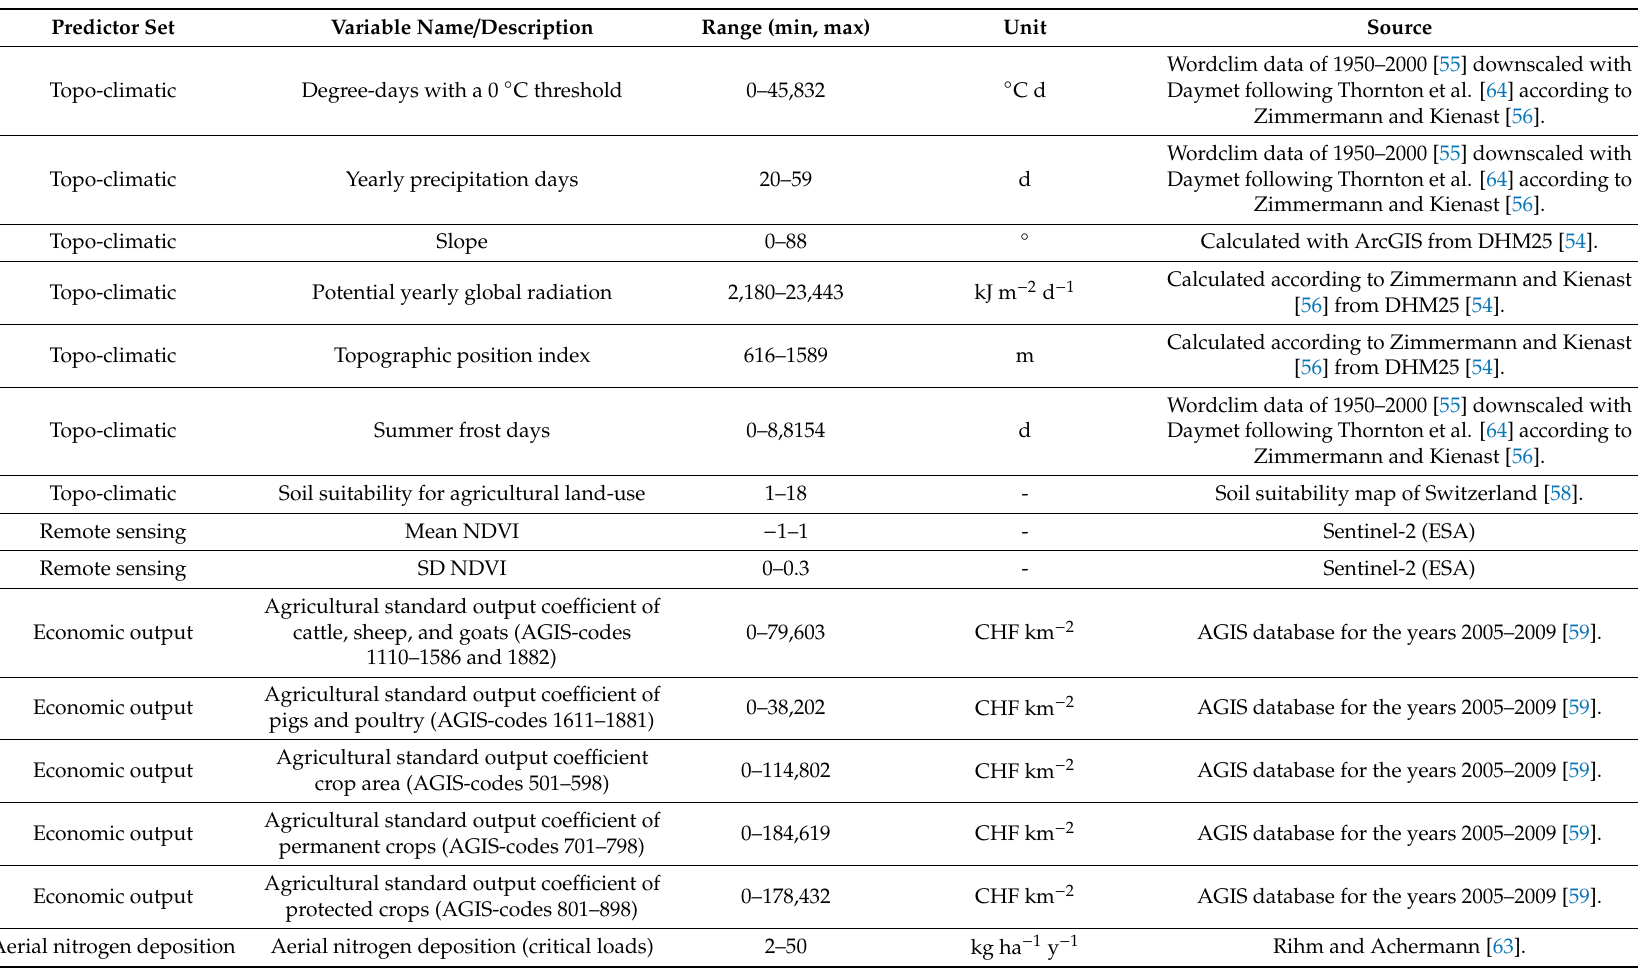
Table 1. Overview of the topo-climatic, economic, and remote-sensing variables and the nitrogen deposition data. Predictor